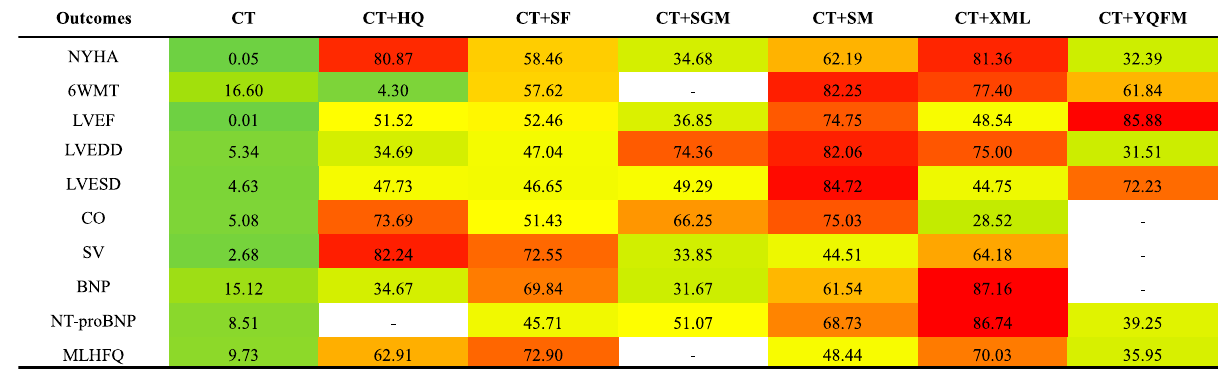
The redder the color, the greater the SUCRA, and the greater the probability of becoming the best intervention. The greener the color, the smaller the SUCRA, and the smaller the probability of becoming the best intervention. NYHA, New York Heart Association cardiac functional classi fi cation ef fi ciency; 6WMT, 6-min walking test; LVEF, left ventricular ejection fraction;LVEDD, left ventricularend-diastolic diameter; LVESD, left ventricular end-systolicdiameter; CO, cardiac output; SV, stroke volume;BNP, brain natriuretic peptide; NT-proBNP, N-terminal pro-brain natriuretic peptide; MLHFQ, Minnesota Living with Heart failure questionnaire; CT, conventional treatment; HQ, Huangqi injection; SF, Shenfu injection;